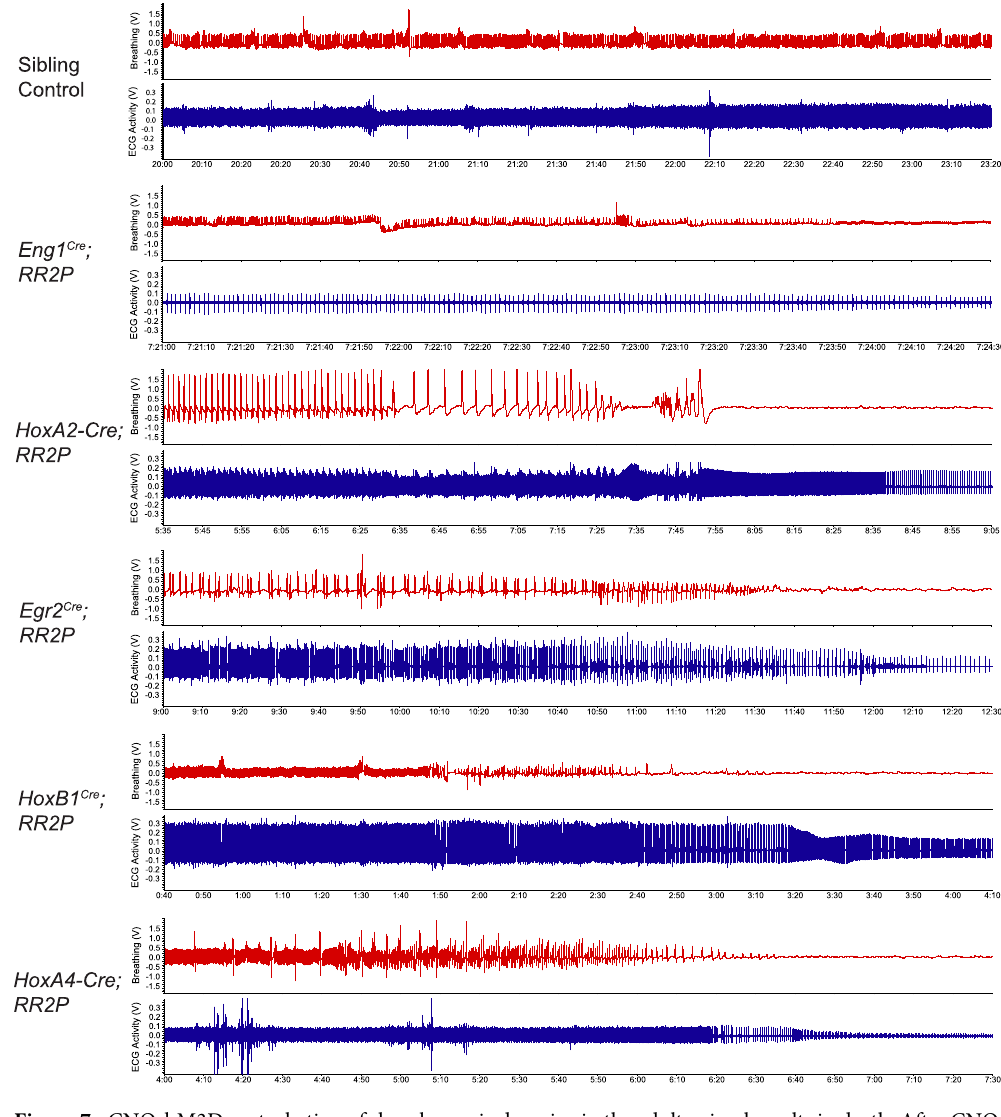
Figure 7. CNO-hM3D perturbation of rhombomeric domains in the adult animal results in death. After CNO injection, rhombomere-Cre; RR2P animals die of cardiovascular or respiratory deficiencies. Examination of the respiratory traces and their alignment with electrocardiogram (ECG) heart traces reveals that each of the 5 rhombomere-Cre; RR2P models has a different course of death. Time shown under each trace is the time after CNO